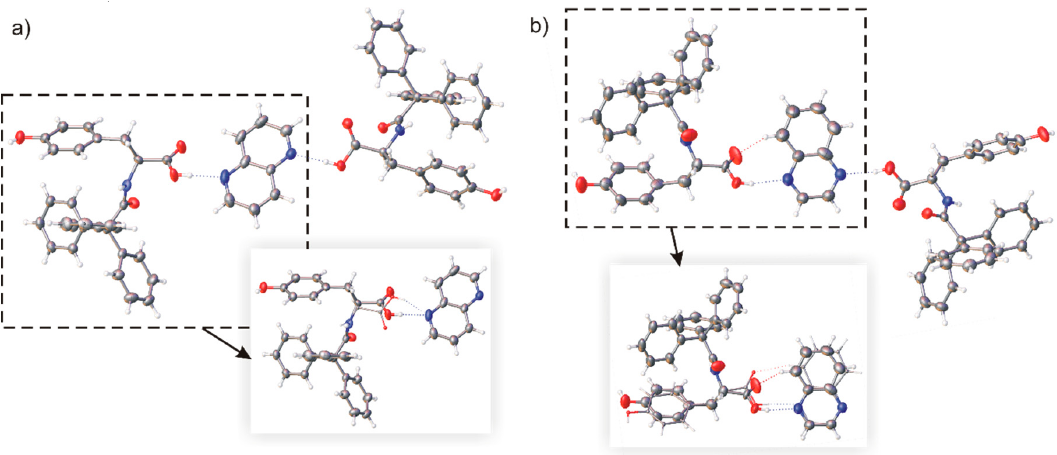
Figure 6. Molecular structure of building blocks in a crystal structure of ( a ) (TrCOTyr) 2 · NPHD and ( b ) (TrCOTyr) 2 · QX; hydrogen bonds are presented as dashed lines, the model of disorder is shown in the frames (minor position indicated by thinner bonds).